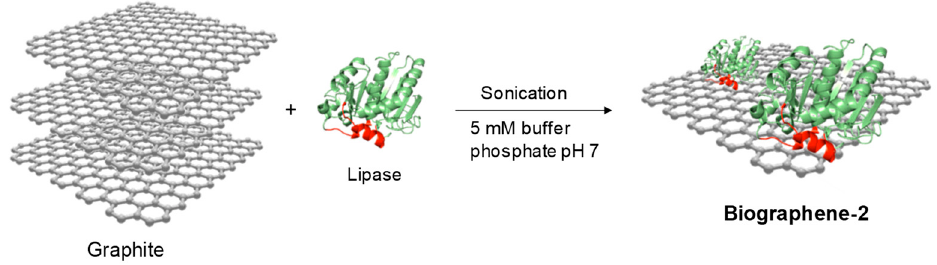
Figure 7. Schematic representation of biographene-2 preparation by Method 4.